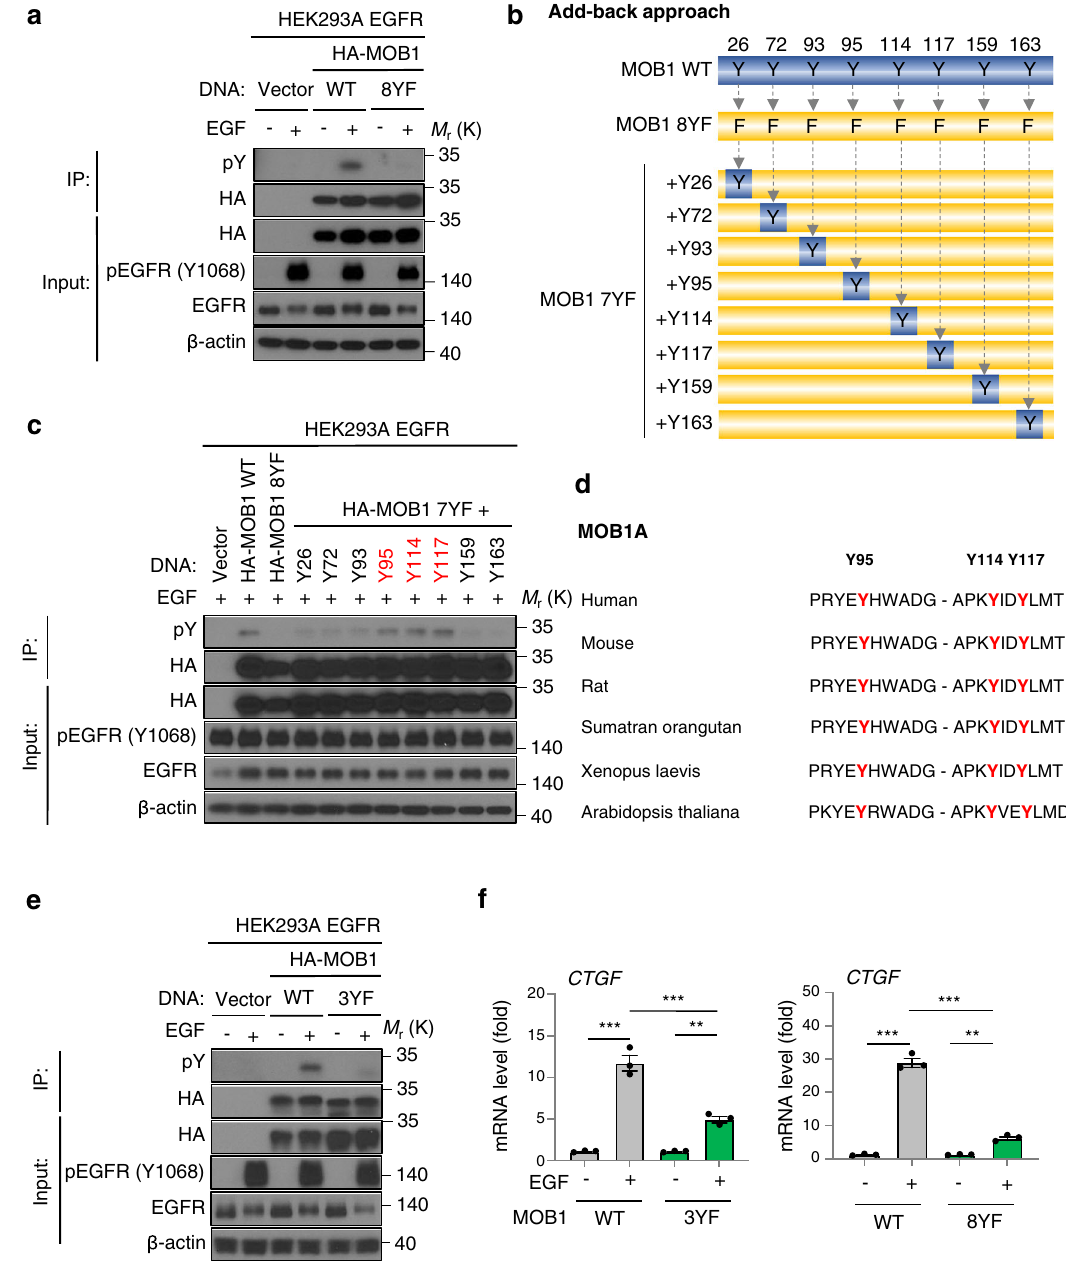
Fig. 4 EGFR activation leads to MOB1 phosphorylation at Y95, 114, 117. a Immunoprecipitation of HA-MOB1 WT and 8YF. Lysates were immunoprecipitated with an antibody against HA-tag. Immunoblot of pY, HA, pEGFR (Y1068), EGFR, β -actin. EGFR-overexpressing HEK293A cells were transfected with HA-MOB1 WT or 8YF plasmid and incubated for 24 h, serum starved for 16 h, and treated with EGF (20 ng/ml) for 1 h. b Schematic of “ Add-back approach ” . All 8 tyrosines of MOB1 WT were mutated into phenylalanine (8YF), then each site was mutated back to tyrosine (7YF + Y). c Immunoprecipitation of HA-MOB1 WT, 8YF and 7YF + Y26, Y72, Y93, Y95, Y114, Y117, Y159, Y163. Lysates were immunoprecipitated with an antibody against HA-tag. Immunoblot of pY, HA, pEGFR (Y1068), EGFR, β -actin. EGFR-overexpressing HEK293A cells were transfected with HA-MOB1 WT, 8YF, and 7YF + Y mutant plasmid and incubated for 24 h, serum starved for 16 h, and treated with EGF (20 ng/ml) for 1 h. d The conserved amino acid sequences at Y95, Y114, Y117 of MOB1A in various species. e Immunoprecipitation of HA-MOB1 WT and 3YF. Lysates were immunoprecipitated with an antibody against HA-tag. Immunoblot of pY, HA, pEGFR (Y1068), EGFR, β -actin. EGFR-overexpressing HEK293A cells were transfected with HA-MOB1 WT or 3YF plasmid and incubated for 24 h, serum starved for 16 h, and treated with EGF (20 ng/ml) for 1 h. f Relative mRNA expression of CTGF . ANOVA with Tukey – Kramer post hoc test was used. Mean ± SEM ( f ); *** P <0.001; ** P downstream of ERK1/2 36 . In response to the activation by the EGFR-MAPK pathway, AP-1 complexes co-occupied distal